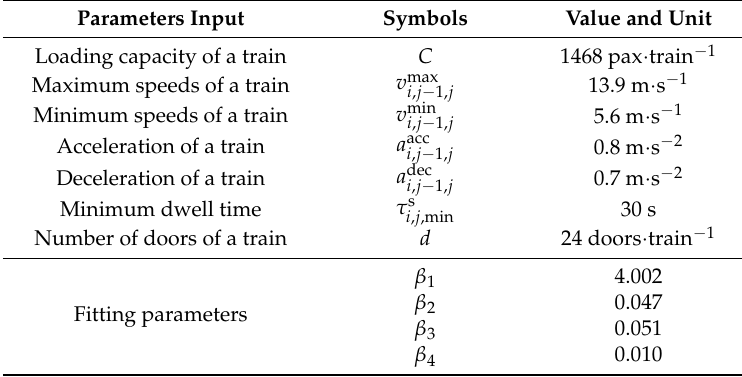
Table 1. Model parameters following appearing orders.